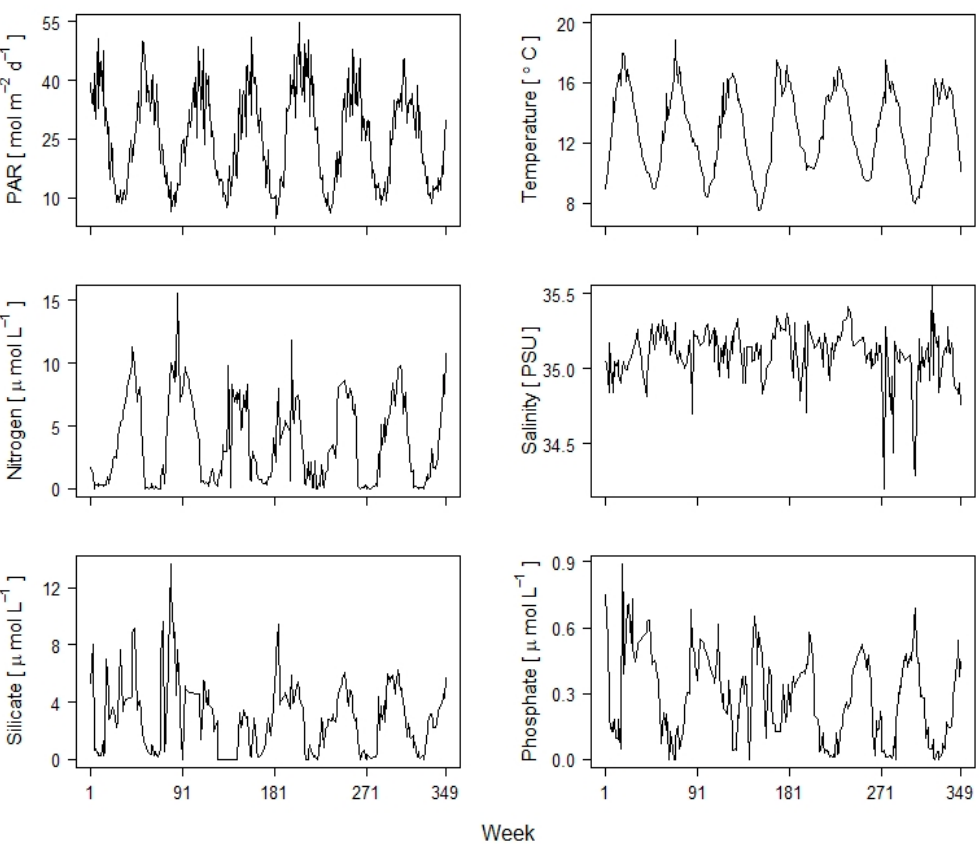
Figure 1. Time plots of environmental variables at Station L4 between 14 April 2003 and 21 December 2009.